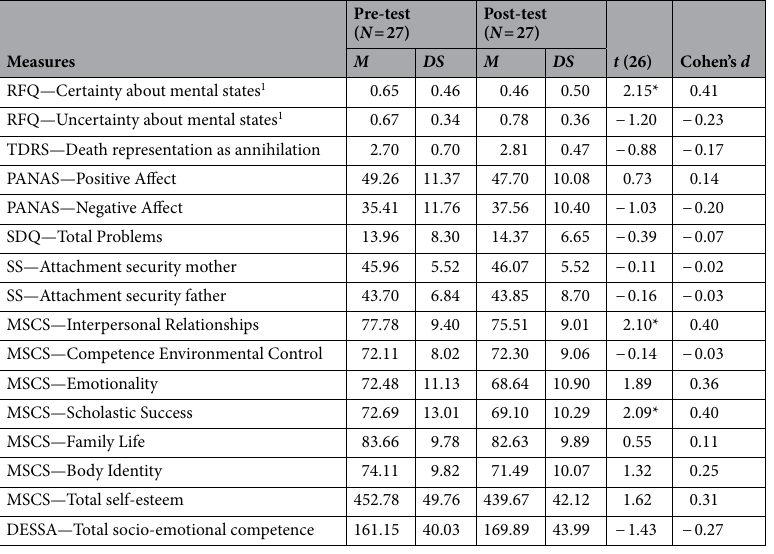
Table 2. Descriptive statistics of study variables for target group at the pre-test and the post-test administration with t-test results and Cohen’s d . 1 A square root transformation was applied to normalize the distribution of the two RFQ factors. * p < .05; ** p < .01; *** p <